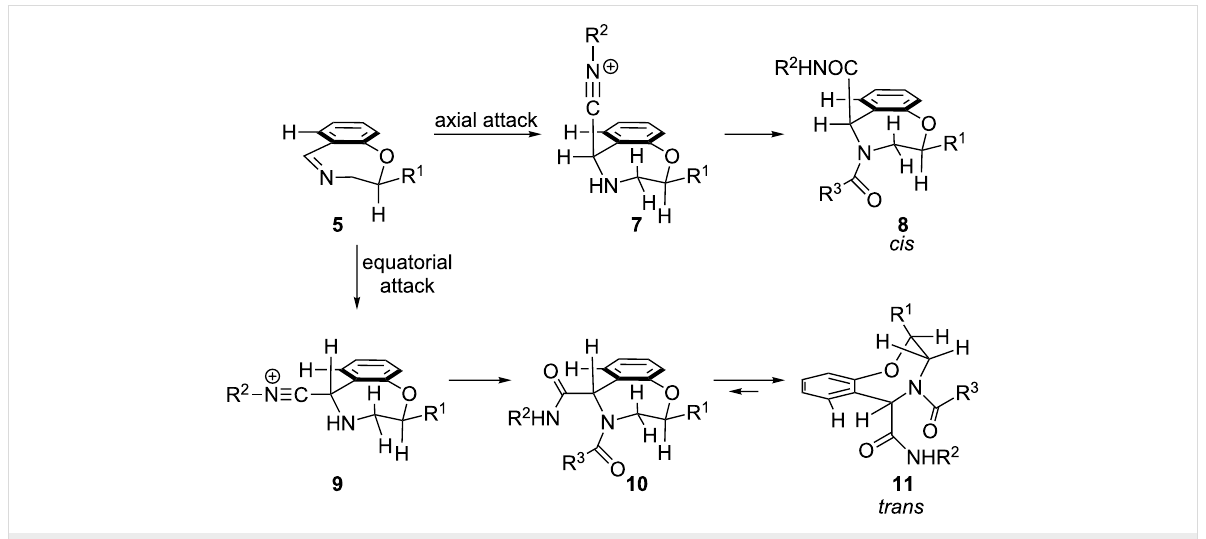
Scheme 2: Possible explanation of diastereoselectivity in Ugi reactions of imines 5 .